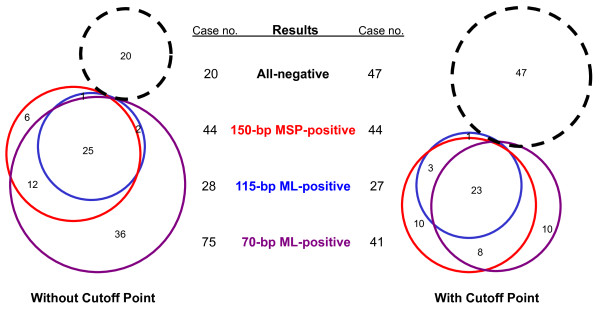
Overlapping information of methylated-p16 by different assays. 102 oral mucosa biopsy samples were tested using three assays; red circles indicate methylated-p16 positive sample numbers as determined using the 150-bp MSP; blue circles indicate methylated-p16 positive sample numbers as determined using the 115-bp novel MethyLight assay; violet circles indicate methylated-p16 positive sample numbers as determined using the 70-bp classic MethyLight assay; the black dashed line circles represent samples without methylated-p16 detected using the three assays; the number within each open area covered by different cycles represents the exact number of samples containing methylated-p16 as detected by the corresponding assays. A: Qualitative results without the use of a cut-off point. B: Summary of the total number of samples with or without methylated-p16 as determined by each assay (left/right case no., without/with cut-off point). C: Qualitative results using a cut-off point for the two MethyLight assays (relative copy number; 0.073 for the classic MethyLight assay, and 0.0002 for the novel MethyLight assay).